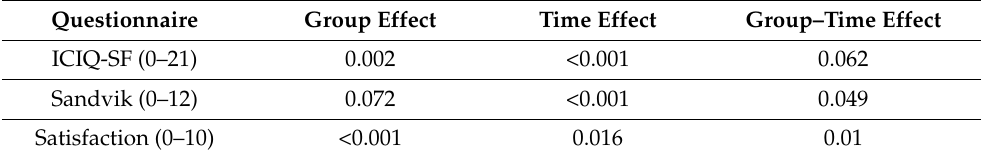
Table 4. Effects of treatment received and their p values for self-assessed